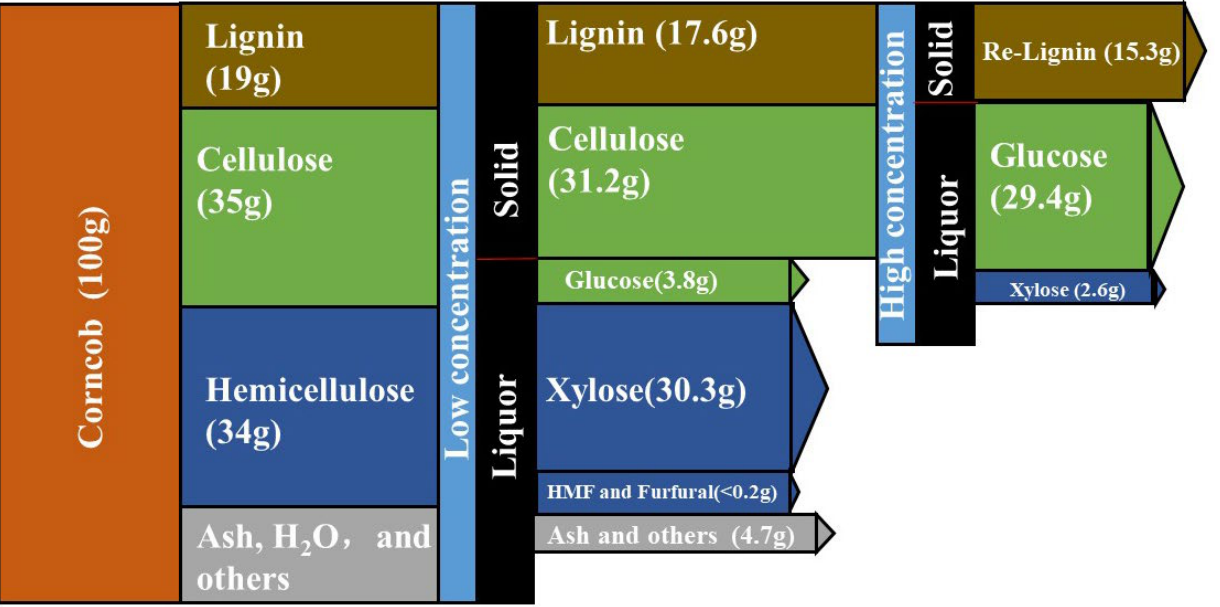
Figure 11. Mass balance flow diagram.